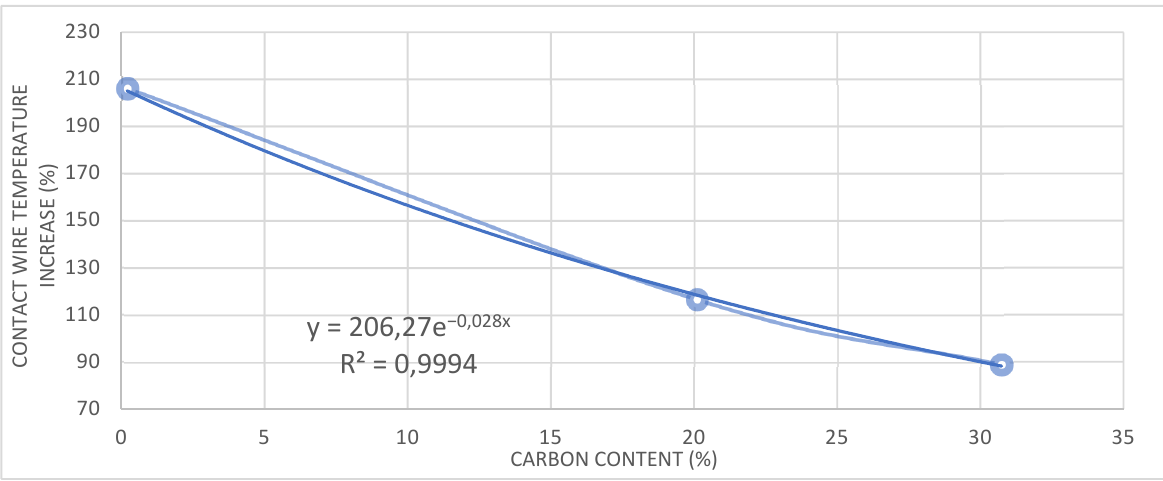
Figure 3. Relation between contact wire temperature and carbon content in a contact strip made of various materials.